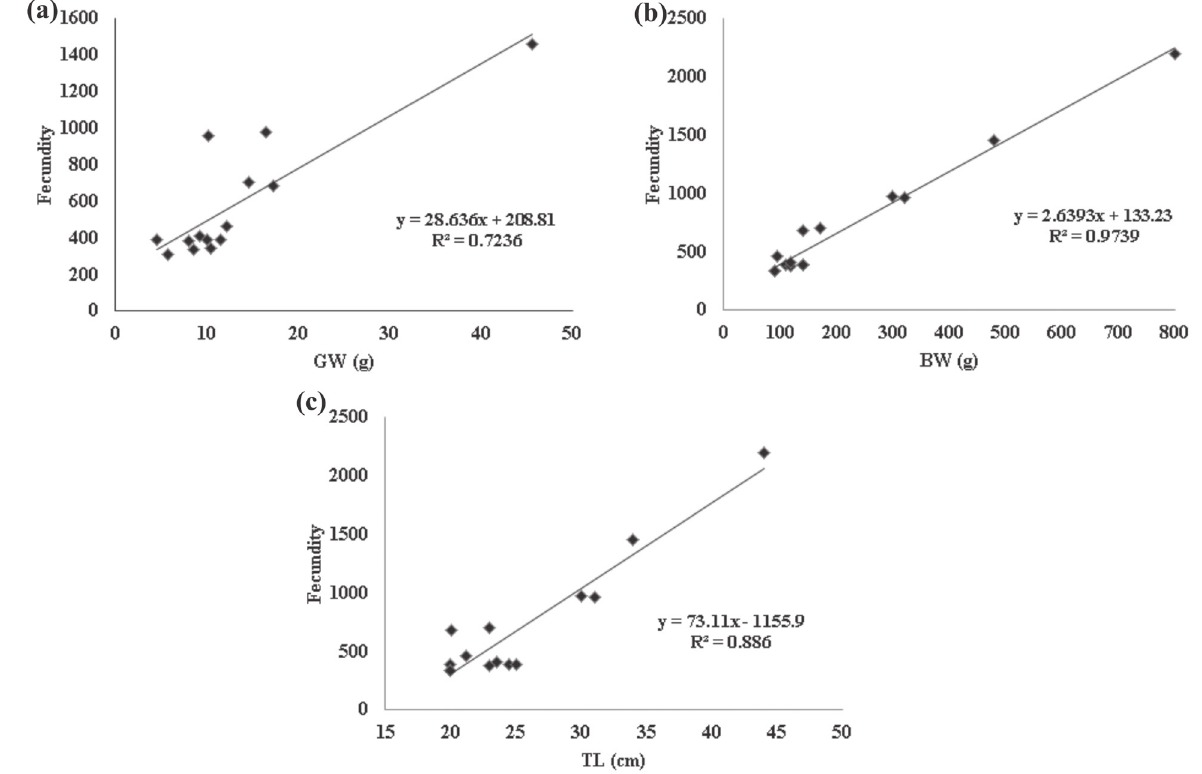
Figure 8 - Fecundity in relation to gonadal weight (GW) (a) , body weight (BW) (b) and total length (TL) (c) of H. francisci females in spawning-capable stage. All analysis showed a statistical difference (p < 0.05).